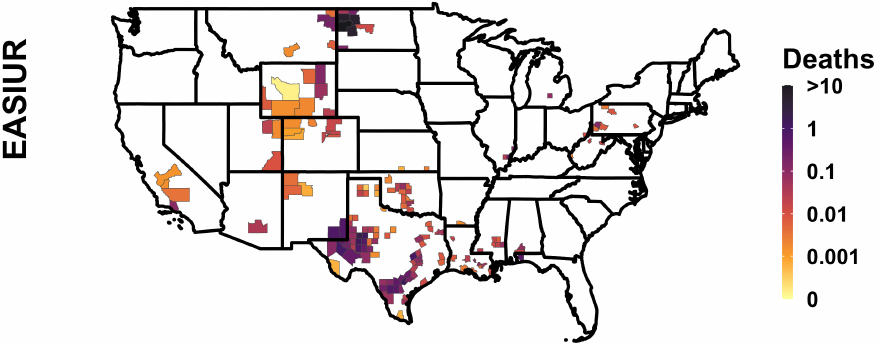
Figure A2. Spatial distribution of flaring-caused mortality simulated by EASIUR, plotted by emis- sion county. Table A1. Energy Information Administration (EIA) data on regional natural gas liquid (NGL) production